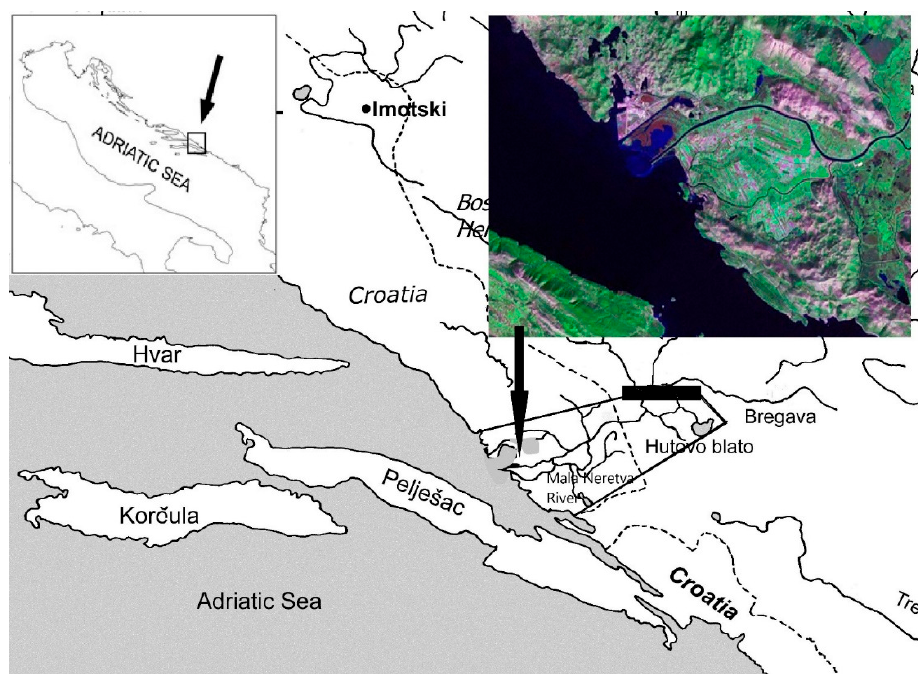
Figure 1. River Neretva Estuary (Eastern Adriatic, Croatia) with Parila lagoon (arrow) where the study was